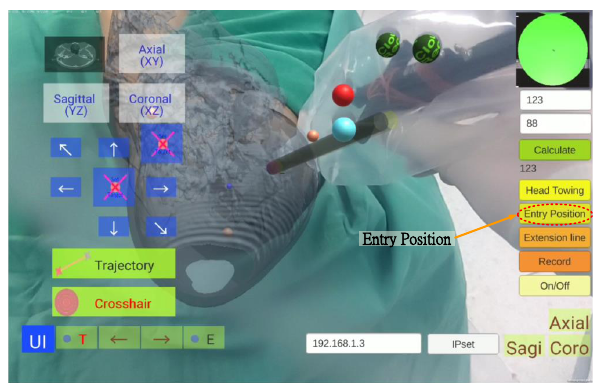
Figure 12. Entry point position